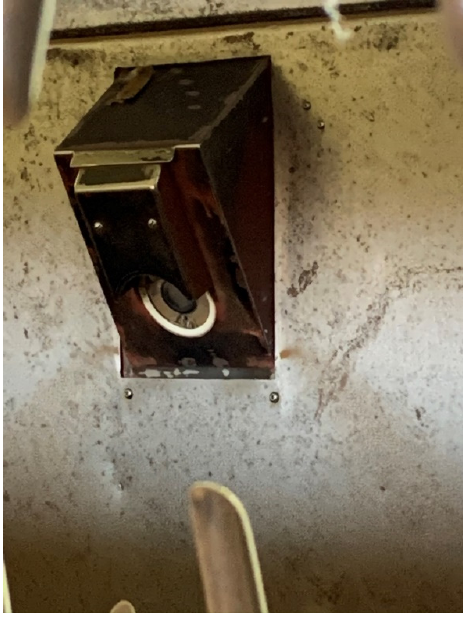
Figure 6. Camera housing as seen from inside the module feeder.